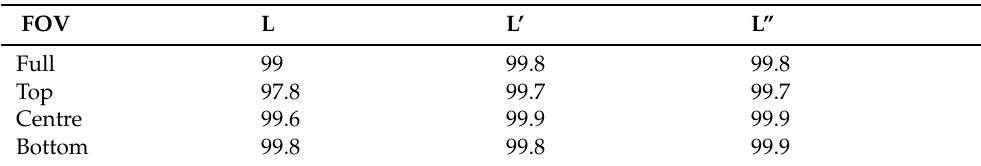
Table 2. Relative accuracy of the length measurements for the different length estimation methods and selected field of view (FOV) in percent (%).